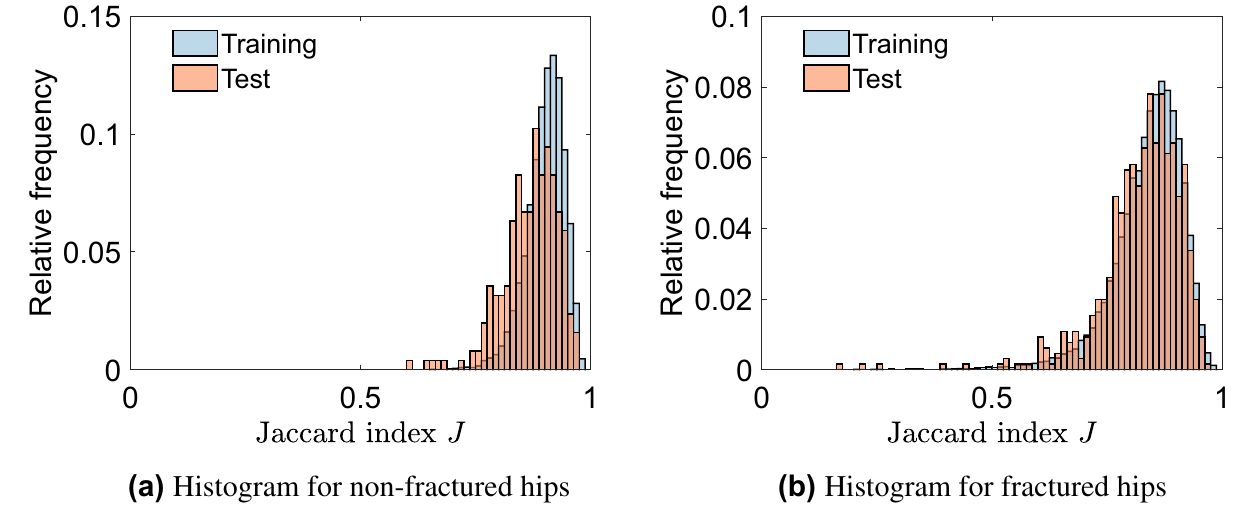
Figure 2. Performance assessment of CNN1 based on the Jaccard index J , which measures the agreement between two images. J = 0 means no agreement and J = 1 means total agreement; J > 0.5 is considered good agreement.